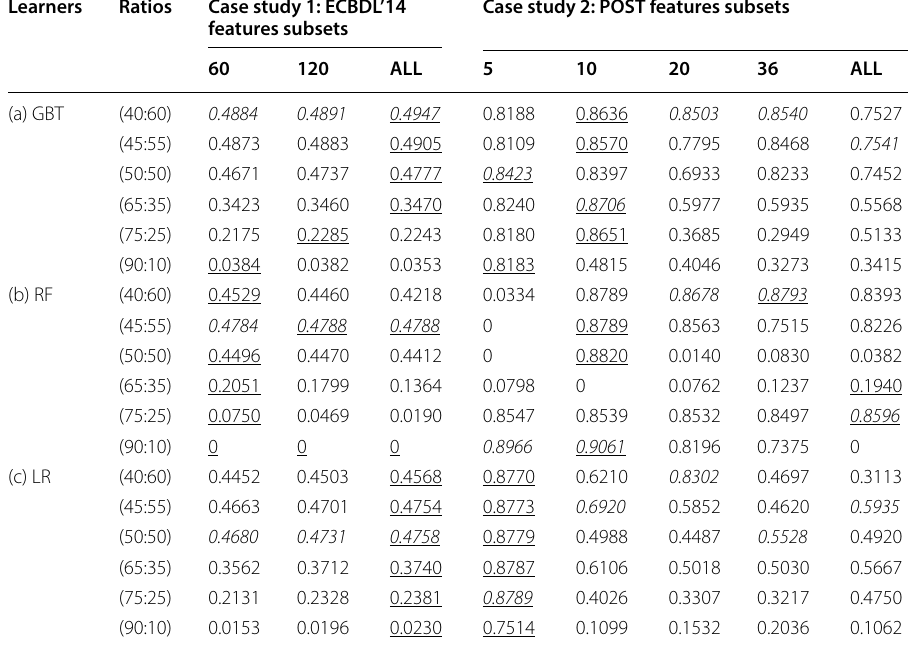
The highest value within each column (features-set) of each sub-table is in italics and the highest value within each row (class distribution ratio) of each sub-table is underlined